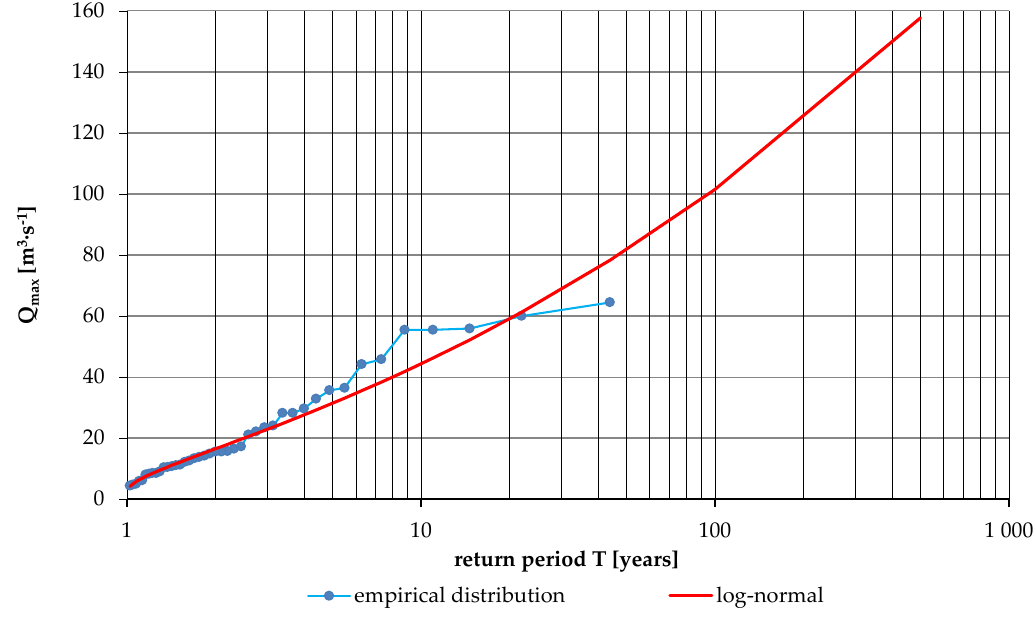
Figure 3. Probability distribution curve for Q max.